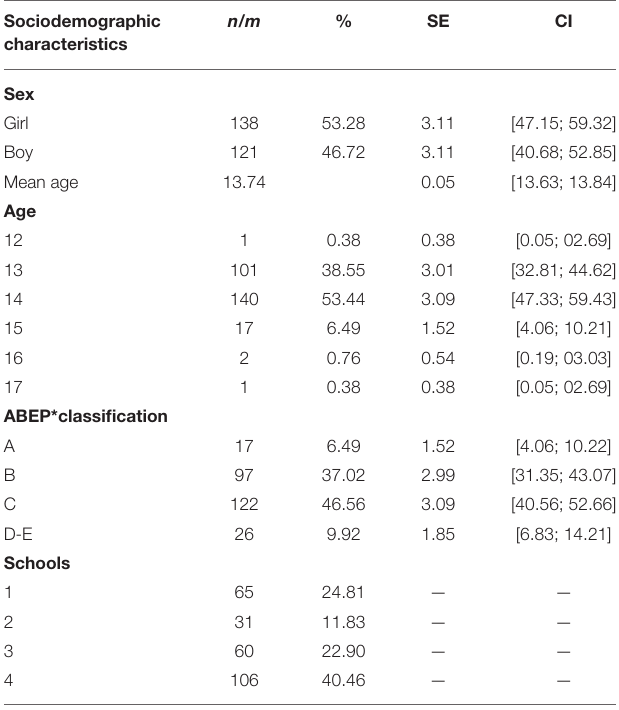
TABLE 2 | Sociodemographic characteristics of public-school students in the city of São Paulo participating in the validation study of the #Tamojunto drug prevention program evaluation questionnaire ( N =